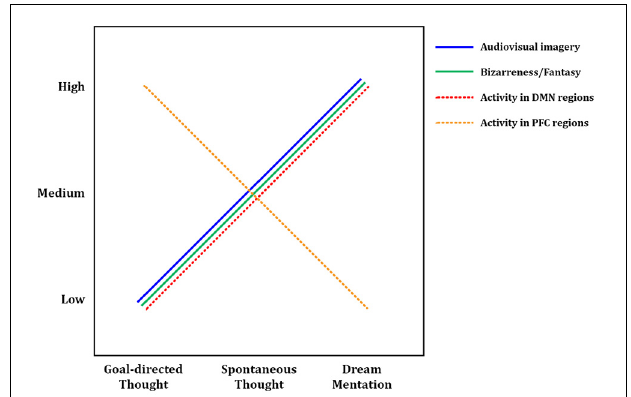
FIGURE 3 | Tentative model of dreaming as intensified mind wandering. A preliminary model of dreaming as an intensified version of waking mind wandering. Intensity of audiovisual imagery, number of bizarre or implausible elements, and activity in DMN regions all appear to increase from waking, goal-directed thought, through waking spontaneous thoughts, to dream mentation. The opposite trend may hold for activity levels in prefrontal executive regions such as anterior cingulate cortex and dorsolateral prefrontal cortex, which are highly active in goal-directed waking thoughts and tasks, only somewhat active during mind wandering (Christoff et al., 2009), and mostly quiescent during dreaming/REM sleep ( Table 2 ). Solid lines represent subjective, experiential elements; dashed lines represent brain activity levels as measured by regional cerebral blood flow using PET, or BOLD (blood-oxygen-level-dependent)signal using fMRI. DMN, default mode network; PFC, prefrontal